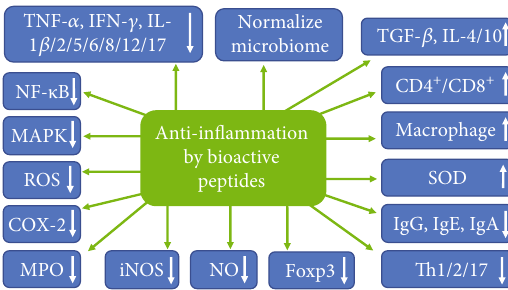
Figure 3: The potential mechanisms of anti-in fl ammatory action of food-derived bioactive peptides. CD4 + /CD8 + : splenic T lymphocyte subpopulations; COX-2: cyclooxygenase-2; Foxp3: a transcription factor that drives treg phenotypic di ff erentiation; iNOS: inducible oxide nitric synthase; IFN- γ : interferon- γ ; IL-1 β : interleukin-1 β ; MAPK: mitogen-activated protein kinase; MPO: myeloperoxidase; NF- κ B: nuclear factor- κ B; NO: nitric oxide; ROS: reactive oxygen species; SOD: superoxide dismutase; TNF- α : tumor necrosis factor α ; TGF- β : transforming growth factor β ; Th1/2/17: T-helper-cell- associated cytokine 1/2/17. This fi gure was adapted from previous reports [7,